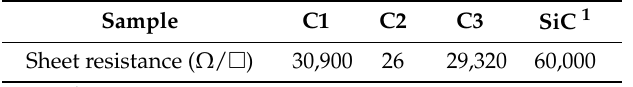
Table 2. Sheet resistance of SiC thin film and graphene inferred by the four points probe method. Sample